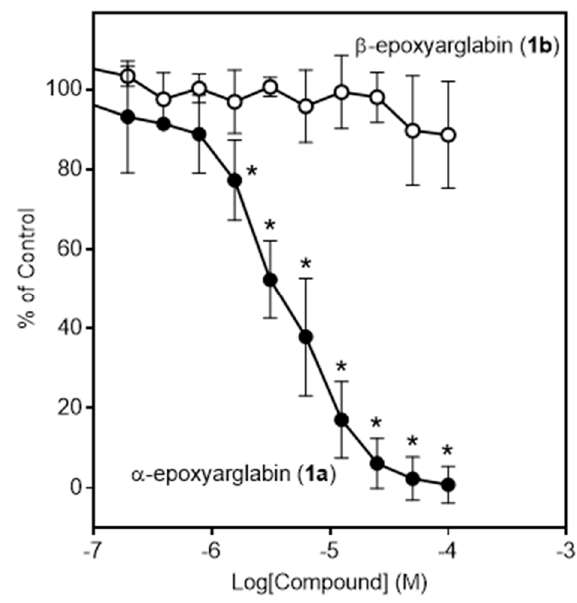
Figure 2. Effect of α -epoxyarglabin ( 1a ) and β -epoxyarglabin ( 1b ) on activation-induced Ca 2+ mobilization in Jurkat T cells. Jurkat T cells were pretreated for 20 min with a control of 1% DMSO or increasing concentrations of the indicated compounds and activated with anti-CD3. Activation-induced Ca 2+ flux was measured as described, and the results are shown as the % of maximal activation measured in the control cells. The results shown in both panels are representative of three independent experiments. Statistically significant differences between cells pretreated with compound 1a versus compound 1b are indicated (* p < 0.01).